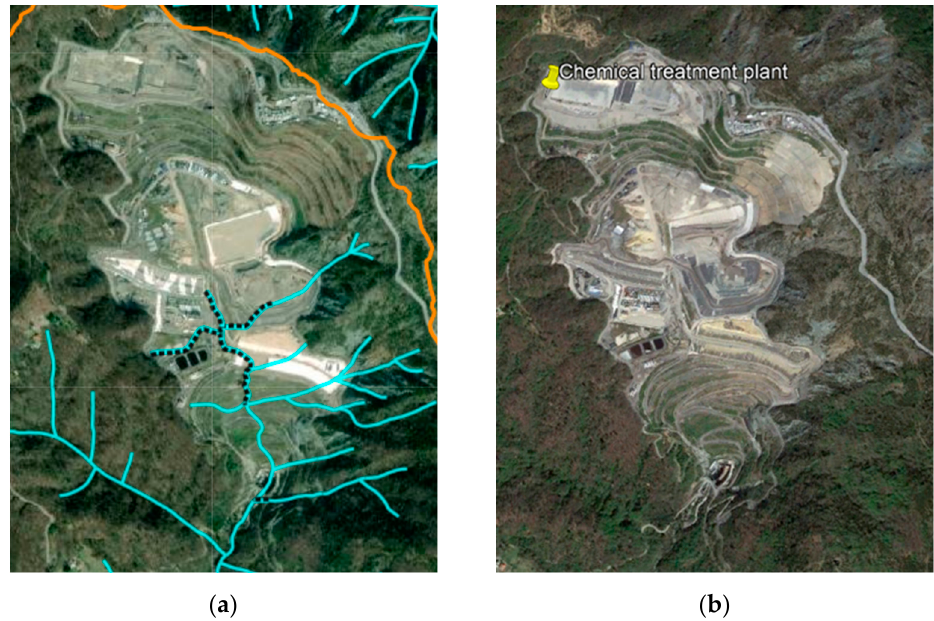
Figure 3. ( a ) Aquifer and waterbody on the Scarpino site; ( b ) Waste plastic treatment plant— simulated position inside the Scarpino